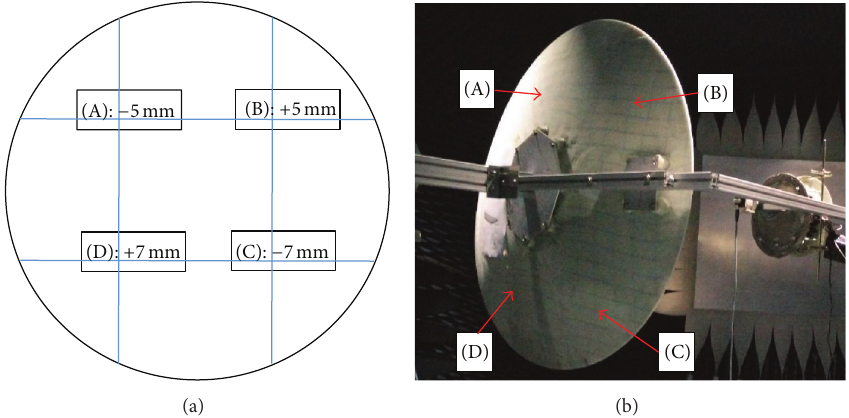
Figure 8: The general setting of the experiment. (a) The distorted main reflector with the errors. (b) The distorted main reflector with the dynamic subreflector during the experiment in the RF